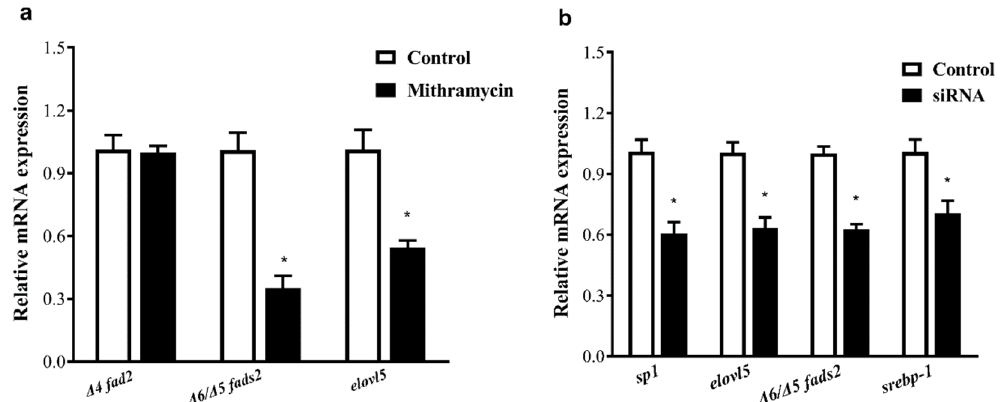
Figure 9. Q-PCR analyses of gene expression in S. canaliculatus hepatocyte line (SCHL) cells: ( a ) treated with the Sp1 antagonist mithramycin, ( b ) transfected with sp1 siRNA or negative control siRNA (NC). Relative expression of the target genes in SCHL cells were quantified for each transcript and was normalized with the expression of 18S rRNA by 2 − ∆∆ Ct method. Results are means ± SEM ( n = 3), * indicates significant differences compared with the control group using Student’s t -test at p < 0.05.